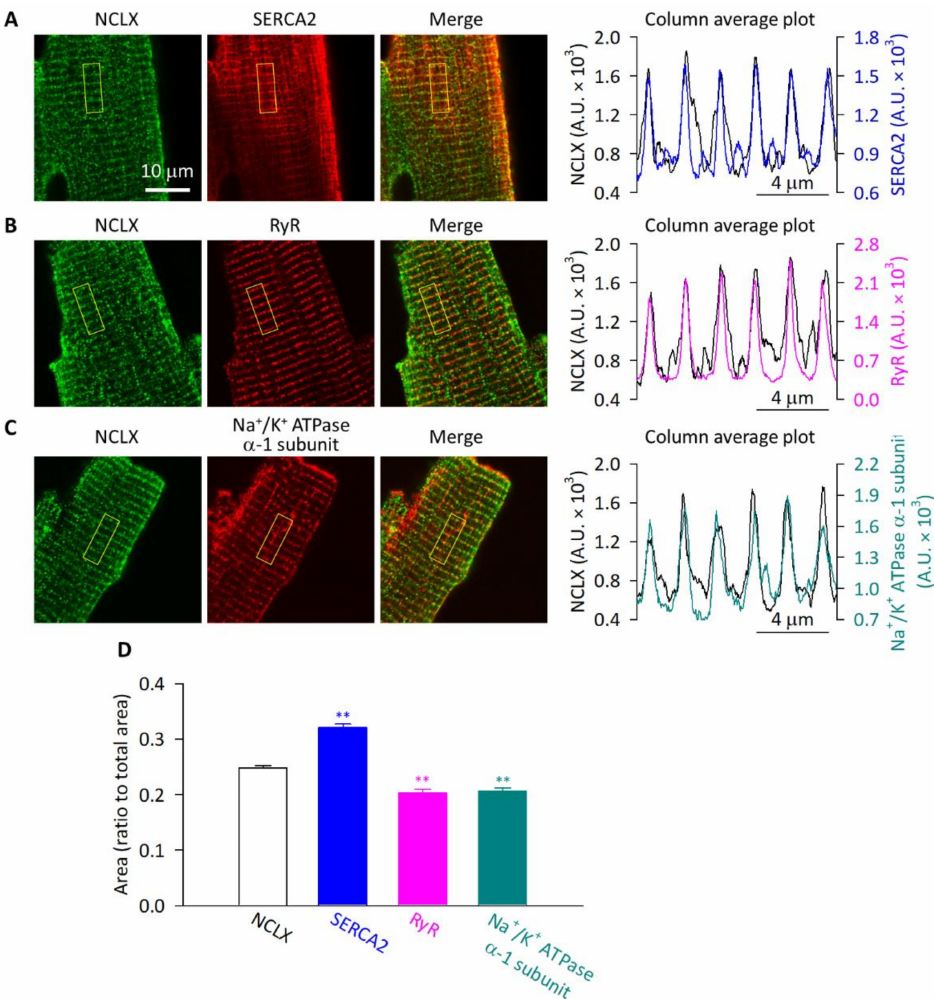
Figure 5. Immunofluorescence analyses of mouse ventricular myocytes. Isolated cells were co- immunostained with anti-NCLX antibody and anti-SERCA2 ( A ), anti-RyR ( B ), and anti-Na + /K + ATPase α -1 subunit ( C ) antibodies, then images were obtained using a conventional confocal mi- croscopy (Leica TCS SP II). NCLX-derived Alexa Fluor 488 signals and SERCA2-, RyR-, and Na + /K + ATPase α -1 subunit-derived Alexa Fluor 633 signals are shown as green and as red, respectively. The merged images are also shown. Column average plots of the six sarcomeres-containing regions highlighted as yellow squares are shown in the rightmost panels. Profiles of NCLX are shown as black lines, and those of SERCA2, RyR, and Na + /K + ATPase α -1 subunit are shown as dark blue, magenta, and cyan, respectively. ( D ) The signal-positive areas in the six sarcomeres-containing regions. Data are expressed as mean ± s.e.m. of 30–91 cells. ** p < 0.01, compared with